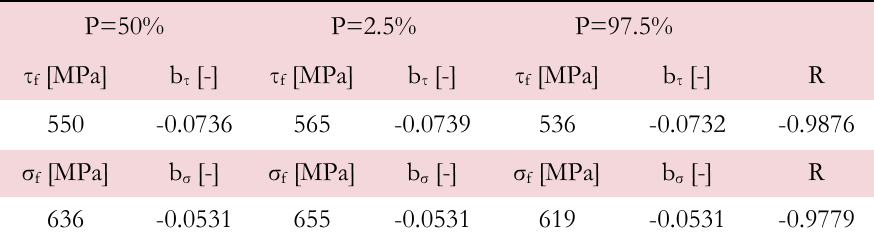
Table 2: Fatigue